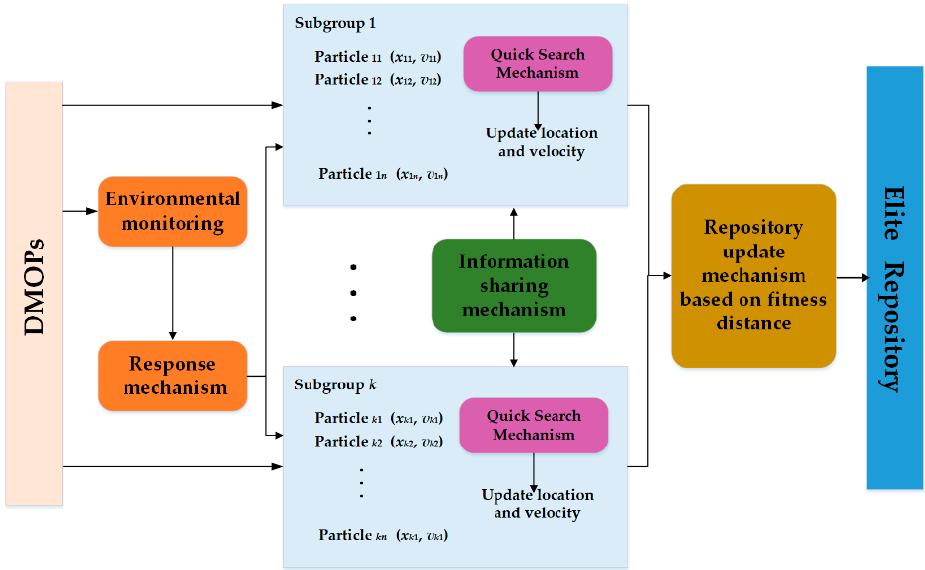
Figure 1. DVEPSO/FD